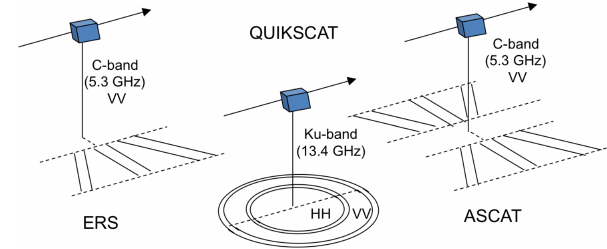
Figure 1. Temporal spans of the satellite scatterometer missions used. Figure 2. Observation geometries of the satellite scatterometers.